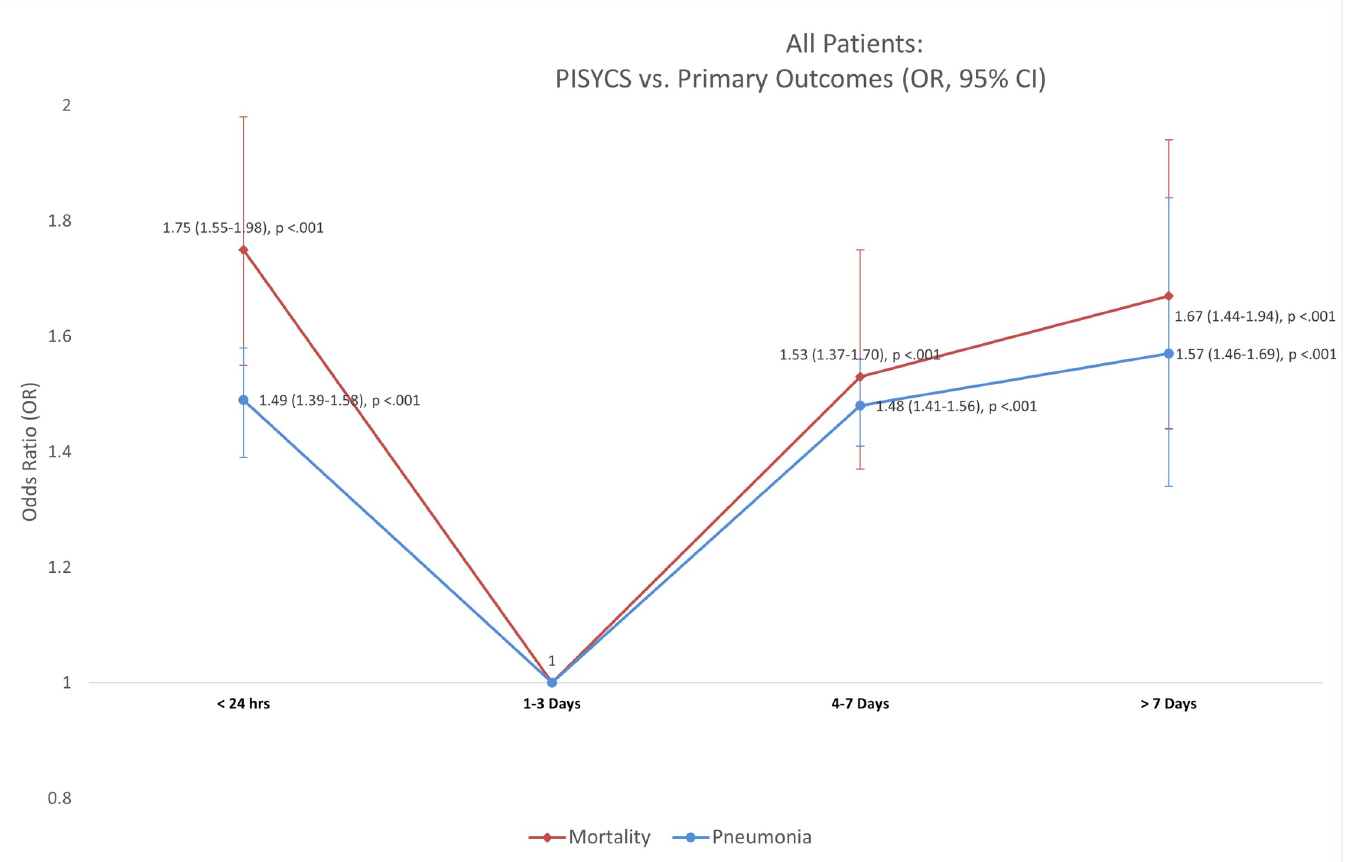
Fig 1. U-shaped distribution of the odds ratio for the primary outcomes (mortality/pneumonia) vs. PISYCS. Association according to the Period between initial symptoms and clinical progression to COVID-19 suspicion (PISYCS) and the primary outcomes of the study (Mortality and Pneumonia), including all patients. A U- shaped distribution is observed, with higher OR for PISYCS < 24 hours and � 4